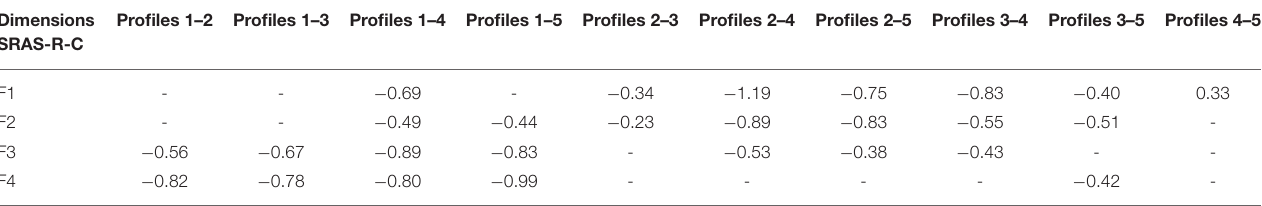
TABLE 5 | Cohen’s d value for post-hoc contrasts between cluster groups on SRAS-R-C dimensions. Dimensions